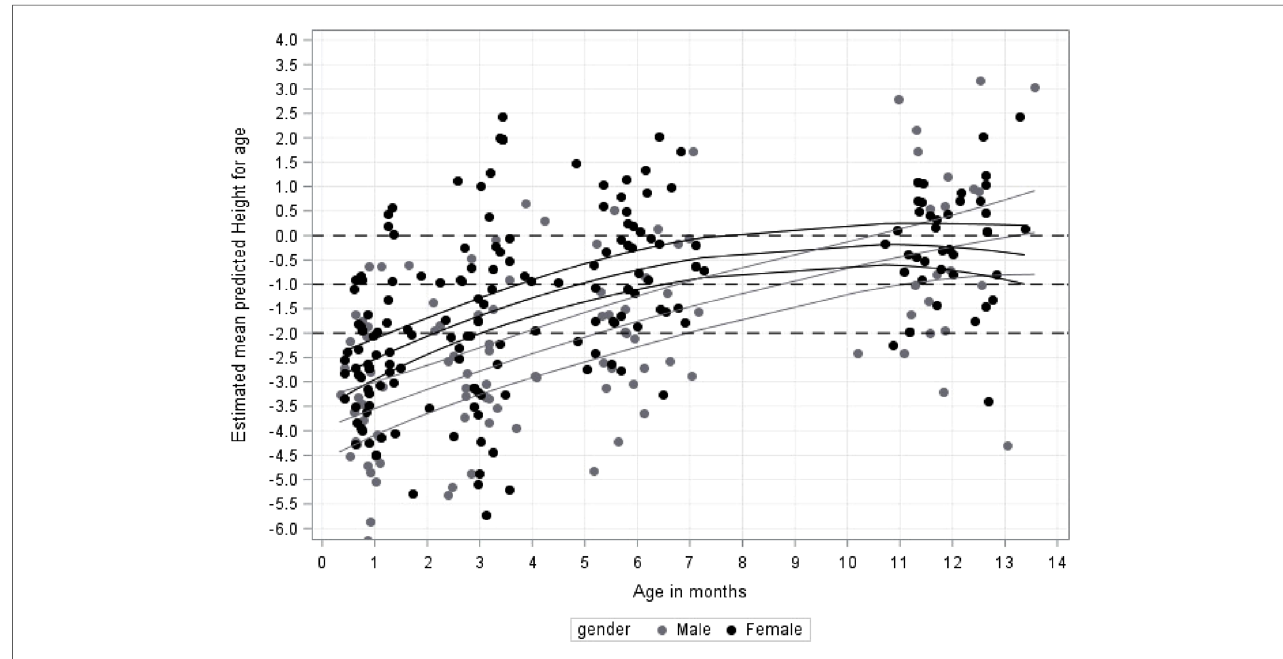
FIGURE 4 Growth for infant ’ s (height-for-age z-scores) (HAZ) in cm from 1 to 12 months by gender.